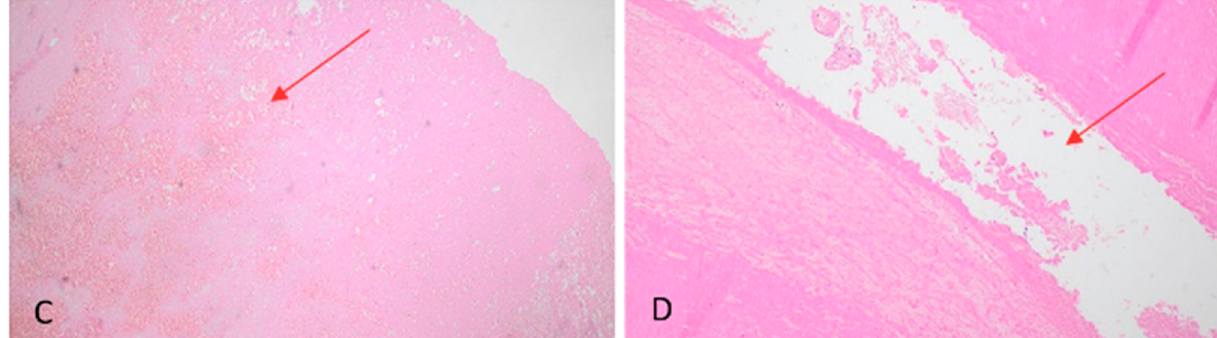
Figure 2. Histology of brain. ( A ) choroid plexus with severe subepithelial edema (red arrow) (H–E × 10); ( B ) intraventricular hematoma in early stage of organization (red arrow) (H–E × 10); ( C ) lysed erythrocytes (red arrow) (H–E × 20); ( D ) flaking choroidal plexus (red arrow) (H–E × 20).